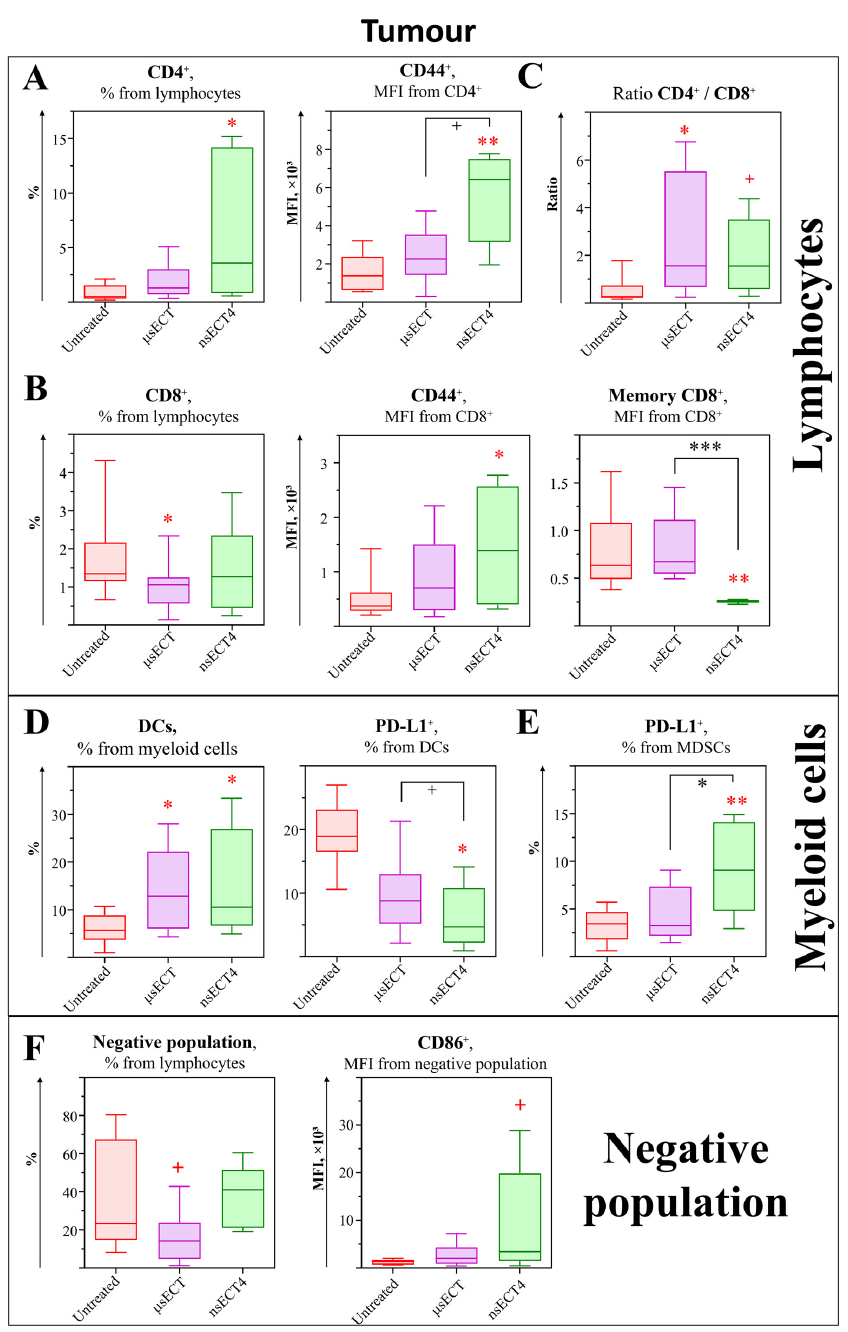
Figure 6. Time-independent study. Lymphocytes ( A – C ), myeloid cells ( D , E ) and “Negative” (Lin − ) population ( F ) in mice tumours. Cytometry was performed with BD FACSAria III cytometer. Statistically significant (* p < 0.05; ** p < 0.005; *** p < 0.0005) differences and tendencies (+ p = 0.05–0.1) compared to the untreated group .